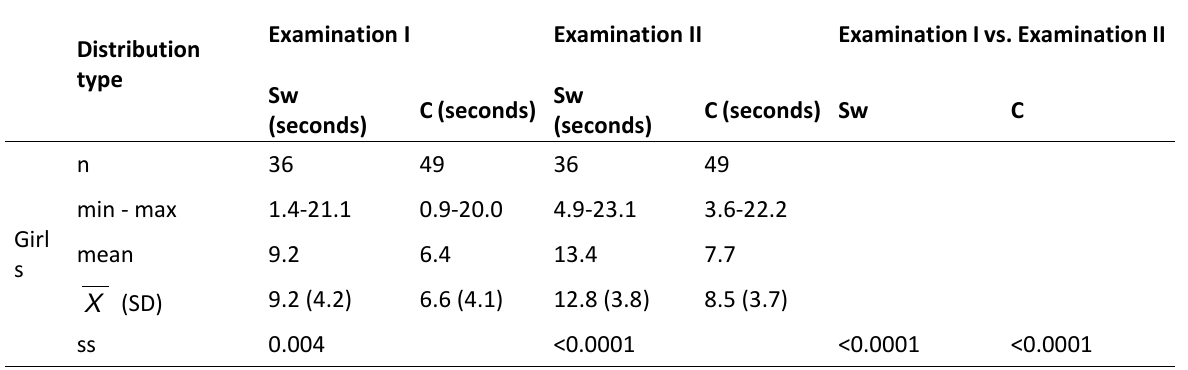
deviation, ss – statistical significance